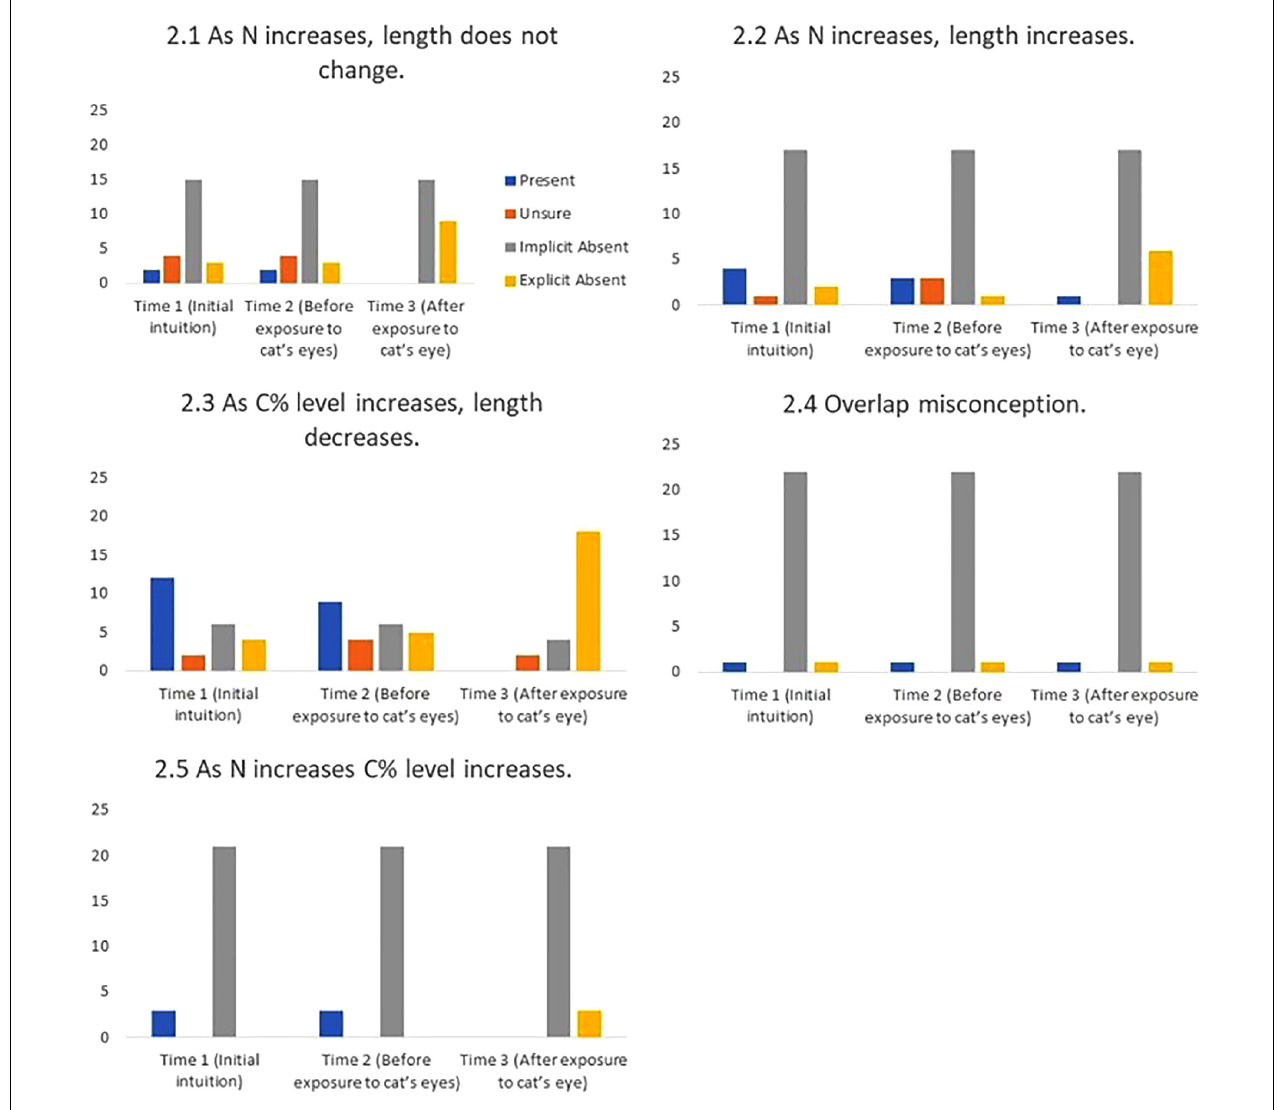
FIGURE 9 | Frequency of students stating intuitions at first mention (Time 1), at last mention immediately before exposure to cat’s eye program (Time 2), and after exposure to cat’s eye program (Time 3) for relational misconceptions ( n =